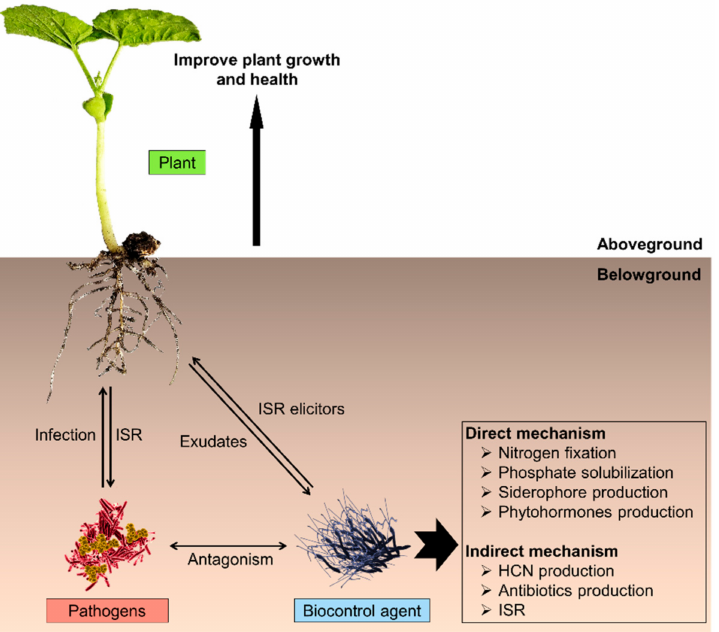
Figure 2. The biological control interactions. The illustration depicts the interactions between biocontrol agents, plant pathogens, and plants. The biocontrol agent colonized the plant root surface and produced antimicrobial compounds such as surfactin. In the plant rhizosphere, antibiosis and nutrient competition interaction suppressed the growth of pathogens. Due to the production of antimicrobial compounds and in the simultaneous presence of pathogens, the induced systemic resistance (ISR) is enhanced. Thus, this mediated the defense response of the plant towards pathogens and consequently improved plant growth and the defense mechanism against